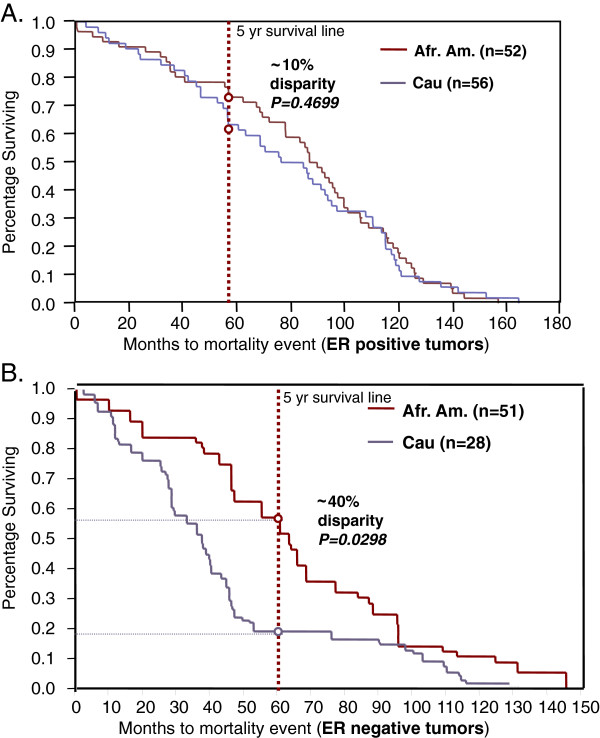
ER status and subgroup survival trends. Compared to the 30% disparity in survival between ethnicity groups for all tumor types (Figure 6), disparities decrease to 10% in the ER positive tumor category (top) and increases to 40% (bottom) in the ER negative tumor category. While both ethnic groups show a lower survival rate in ER negative tumor groups, the survival is far worse in the African American group.